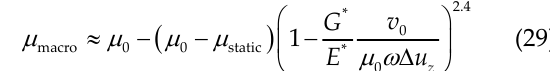
/ 1.2, 1.4, 1.6, u u   ,0 z z